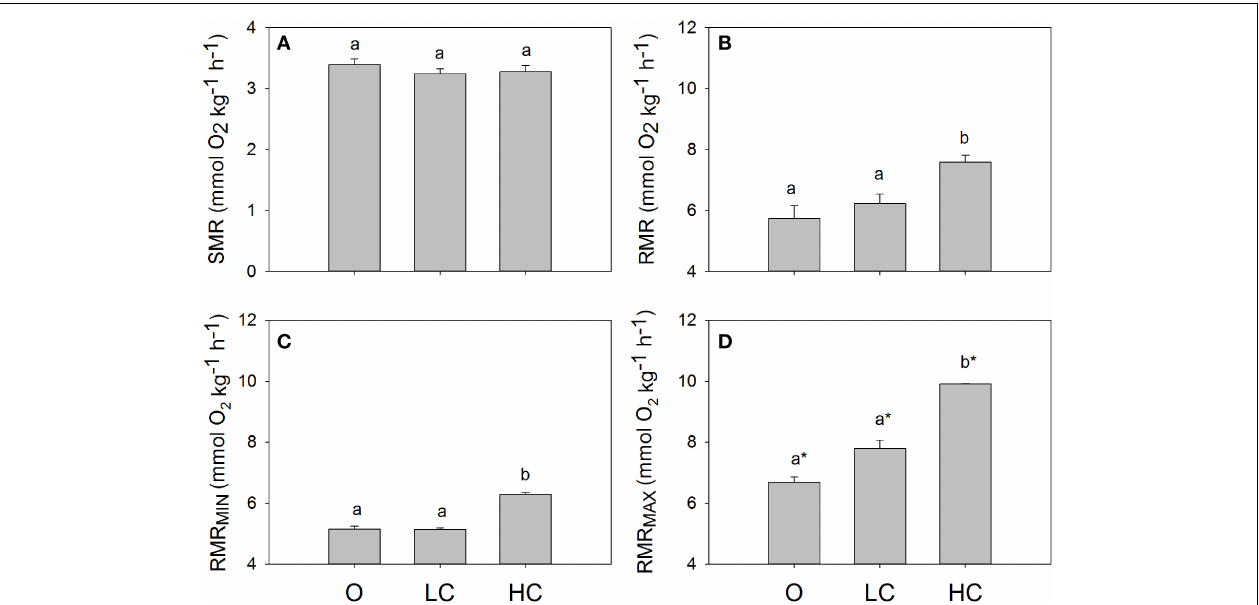
FIGURE 3 | Standard and routine metabolic rates for fish reared at different current speeds. (A) Standard metabolic rate, SMR, (B) daily mean, (C) minimum and (D) maximum routine metabolic rates, RMR. Superscripts indicate significant differences between treatments. High current, HC = 1 BL